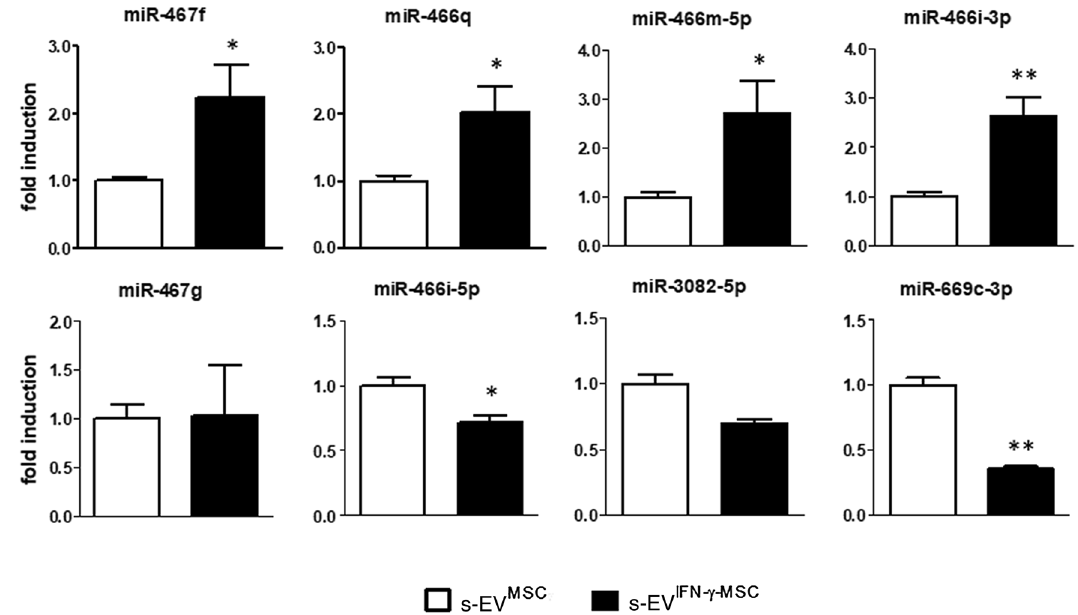
Figure 2. S-EV derived from MSCs primed or not with IFN-γ are differentially enriched in miRNAs. RT-PCR quantification of miRNAs shown by microarray to be dysregulated in immunomodulatory MSCs. * P < 0.05 and ** P < 0.01, s-EV MSC vs s-EV IFN-γ-MSC . Data are presented as mean ± SEM of 3 independent experiments conducted in